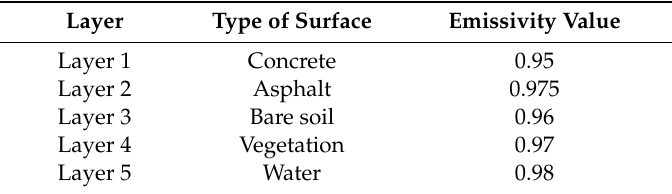
Figure 6. ( a – e ) Emissivity corrected fraction images for individual classes. ( f ) Emissivity corrected image created from proportional layers for each class. Processed using ArcGIS, ENVI, and ERDAS Imagine. Table 3. Emissivity values for different surfaces [52,53].